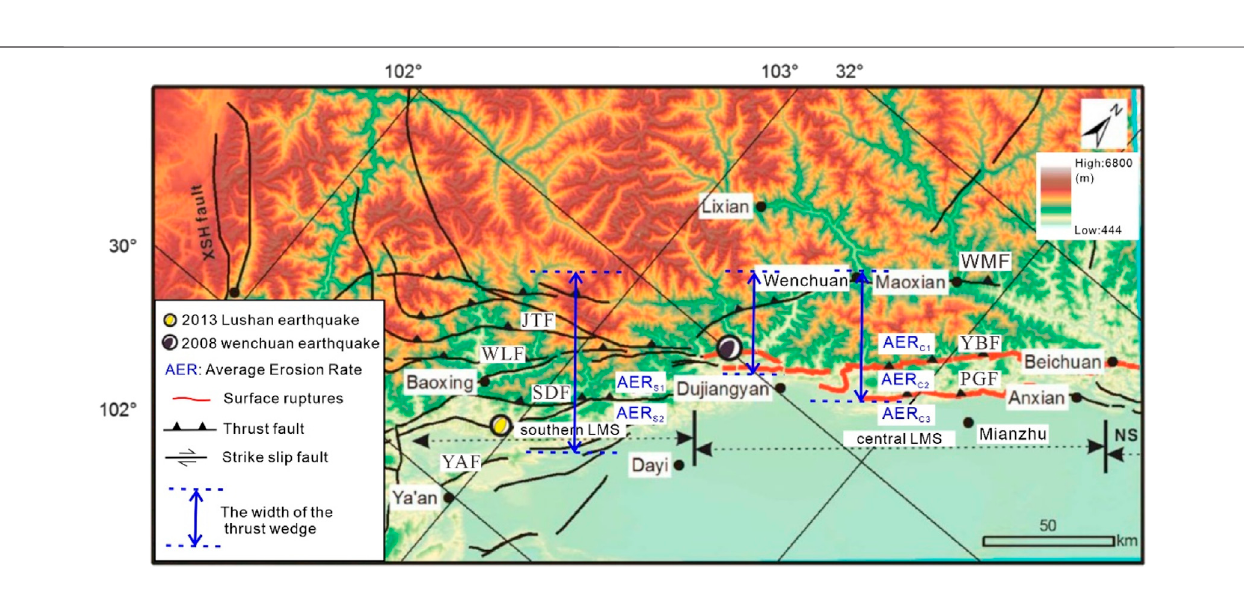
Frontiers in Earth Science |